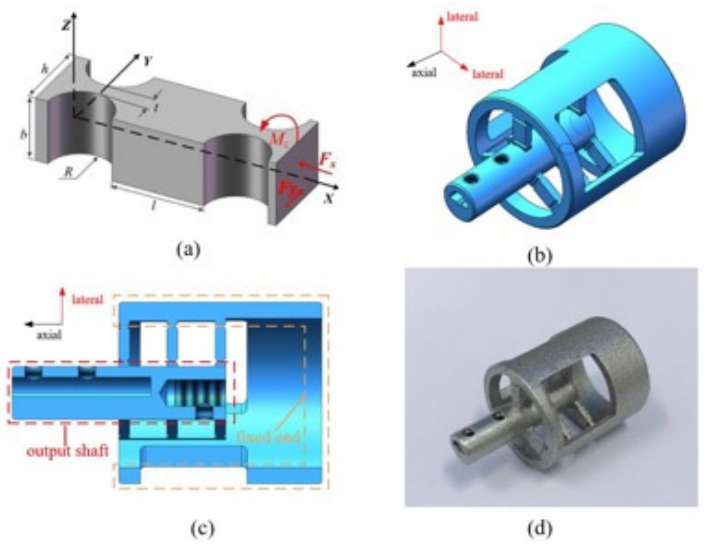
Figure 3. Optimized design and production process of flexure mechanism: ( a ) Schematic diagram of flexure hinge; ( b ) isometric drawing of flexure mechanism; ( c ) sectional view of flexure mechanism; ( d ) physical picture of flexure mechanism.